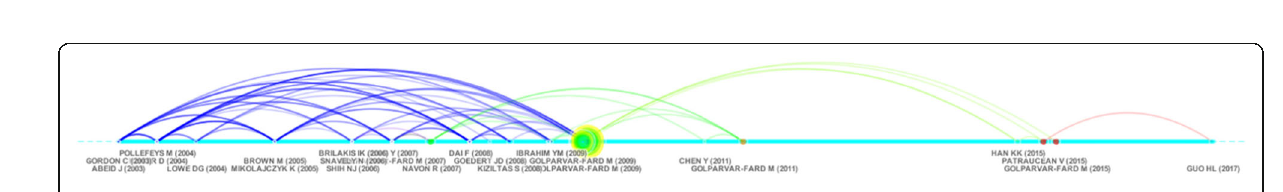
Fig. 19 Timeline view of topic 7